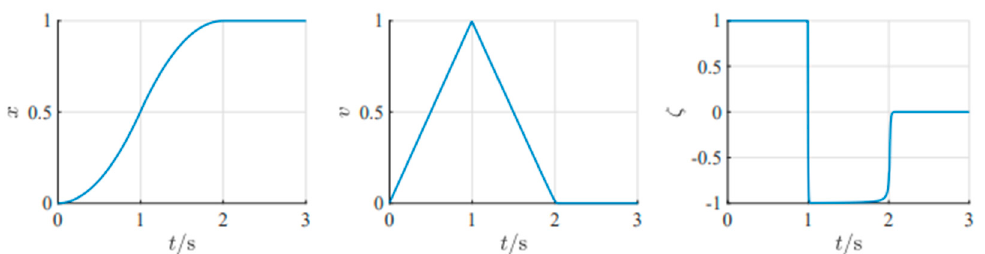
Figure 2. Variation curves of basic TD signal vs. time. Reprinted with permission from refs. [16,17].